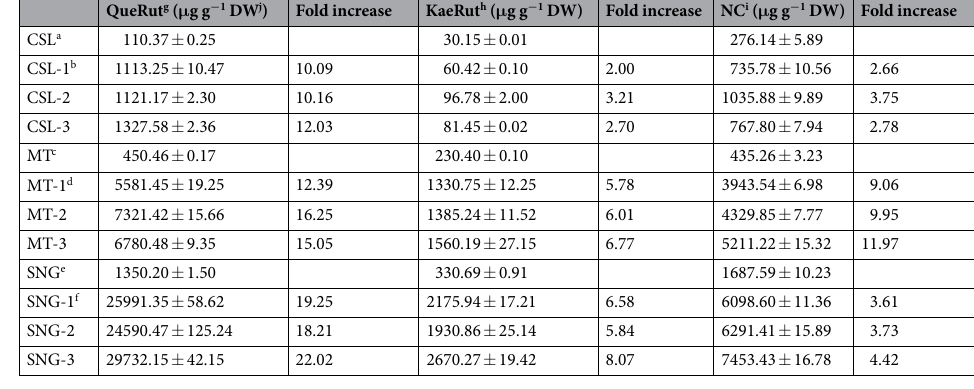
Table 2. Quantification of major flavonols in three wild-type and SlMYB12 -expressing cherry tomato variety peels. a CSL, wild-type (Csl09-03) tomato peels; b CSL-1, 2,3, three lines of SlMYB12 -expressing tomato (CSL variety); c MT, wild-type (Micro Tom) tomato peels; d MT-1, 2,3, three lines of SlMYB12 -expressing tomato (MT variety); e SNG, wild-type (Sheng Nv-Guo) tomato peels; f SNG-1, 2,3, three lines of SlMYB12 -expressing tomato (SNG variety); g QueRut, quercetin rutinoside (rutin); h KaeRut, kaempferolrutinoside; i NC, naringenin chalcone; j DW, dry